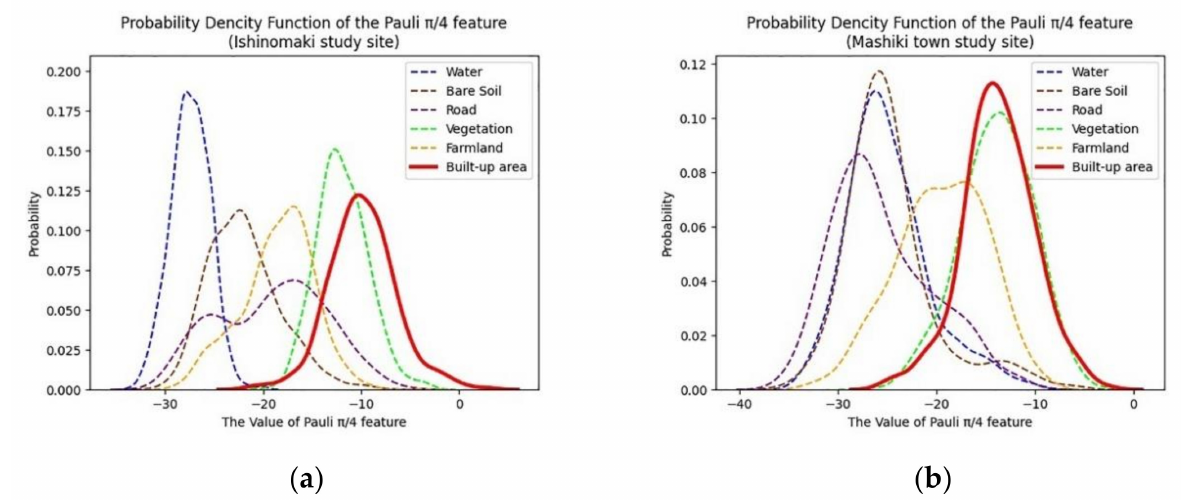
Figure 11. The probability density function (pdf) of the Pauli π /4 feature of six kinds of samples in different study sites: ( a ) Ishinomaki study site; ( b ) Mashiki town study